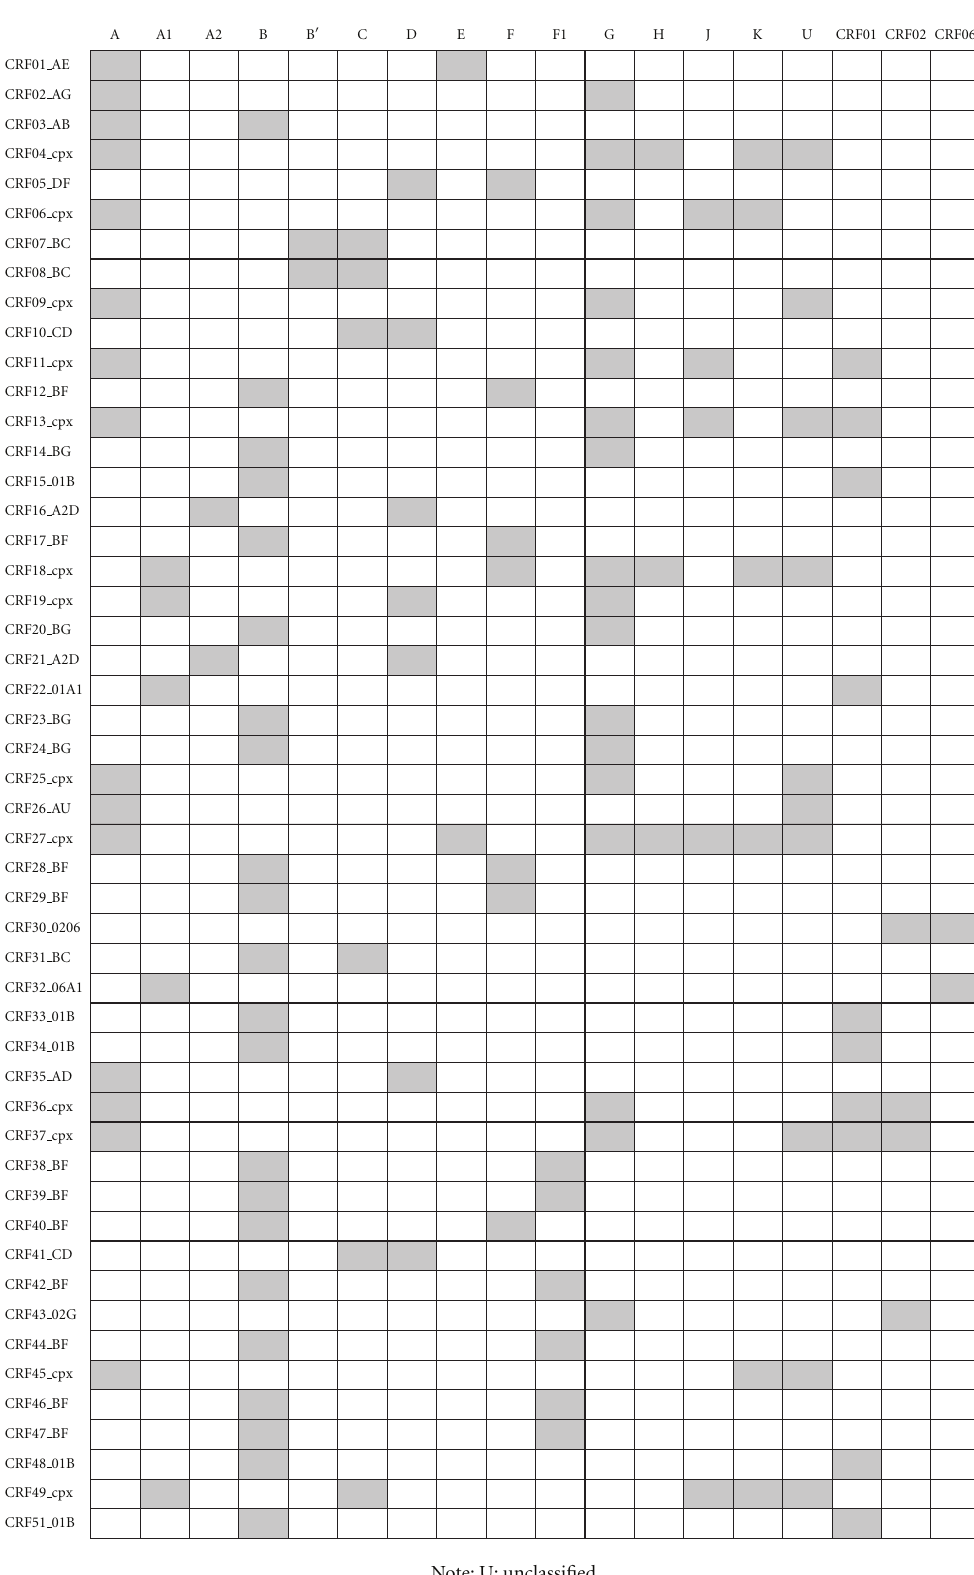
Figure 2: Schematic representation of composition of HIV-1